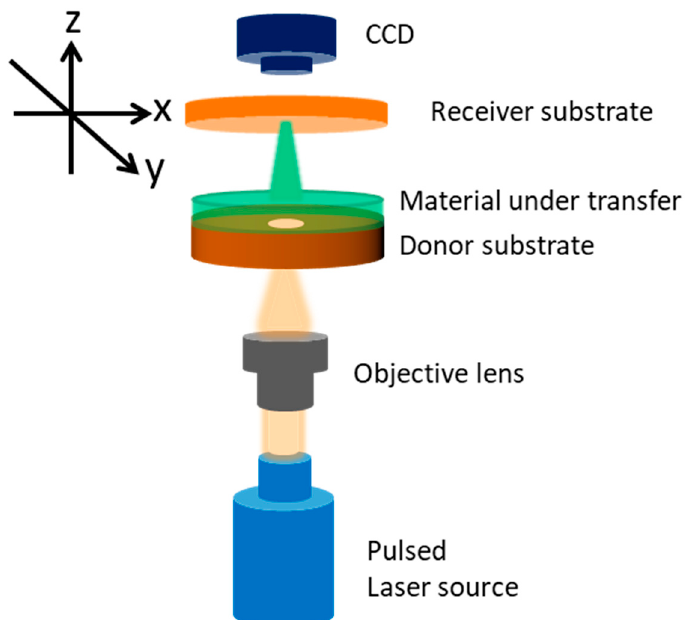
Scheme 1. Schematic illustration of the laser induced forward transfer (LIFT) experimental setup.